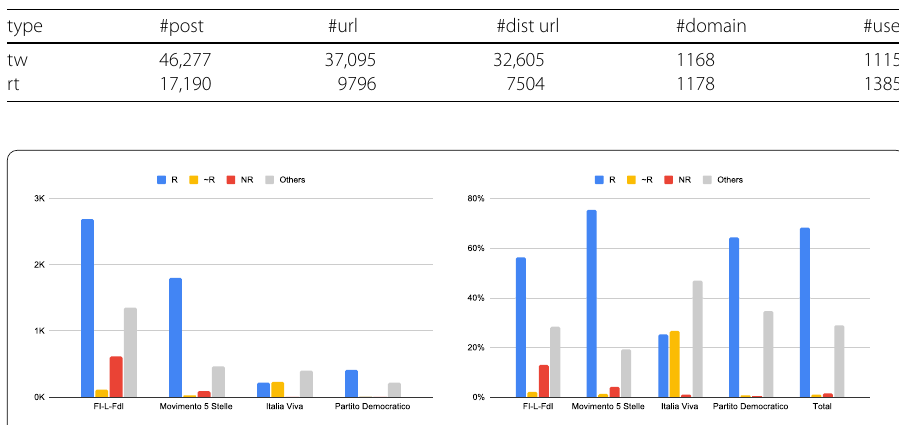
Table 3 Posts, urls, domains and users statistics in the validated network of verified users. “Tw” represent pure tweets, while “rt” indicates retweets. The number of tweets sharing an url is much higher than the one of retweets and it is a known results for verified users, from which they appear to drive the online debate